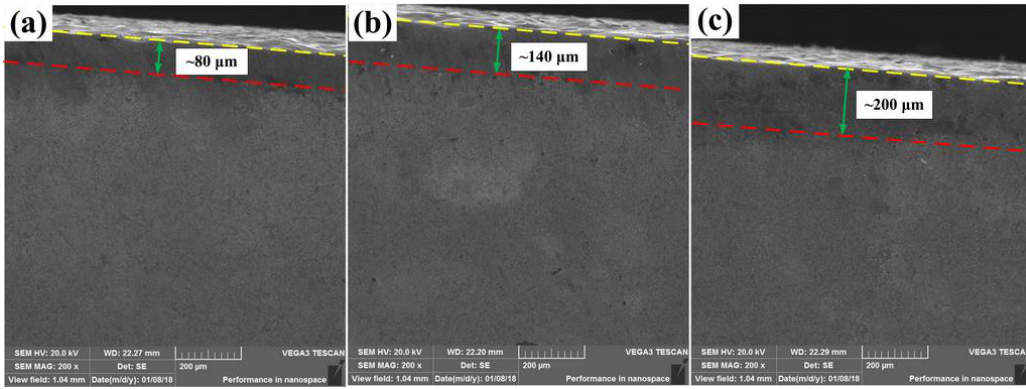
Figure 9. The cross-sectional scanning electron microscope (SEM) observation of shot peening specimens: ( a ) SP1 specimen; ( b ) SP2 specimen; ( c ) SP3 specimen.